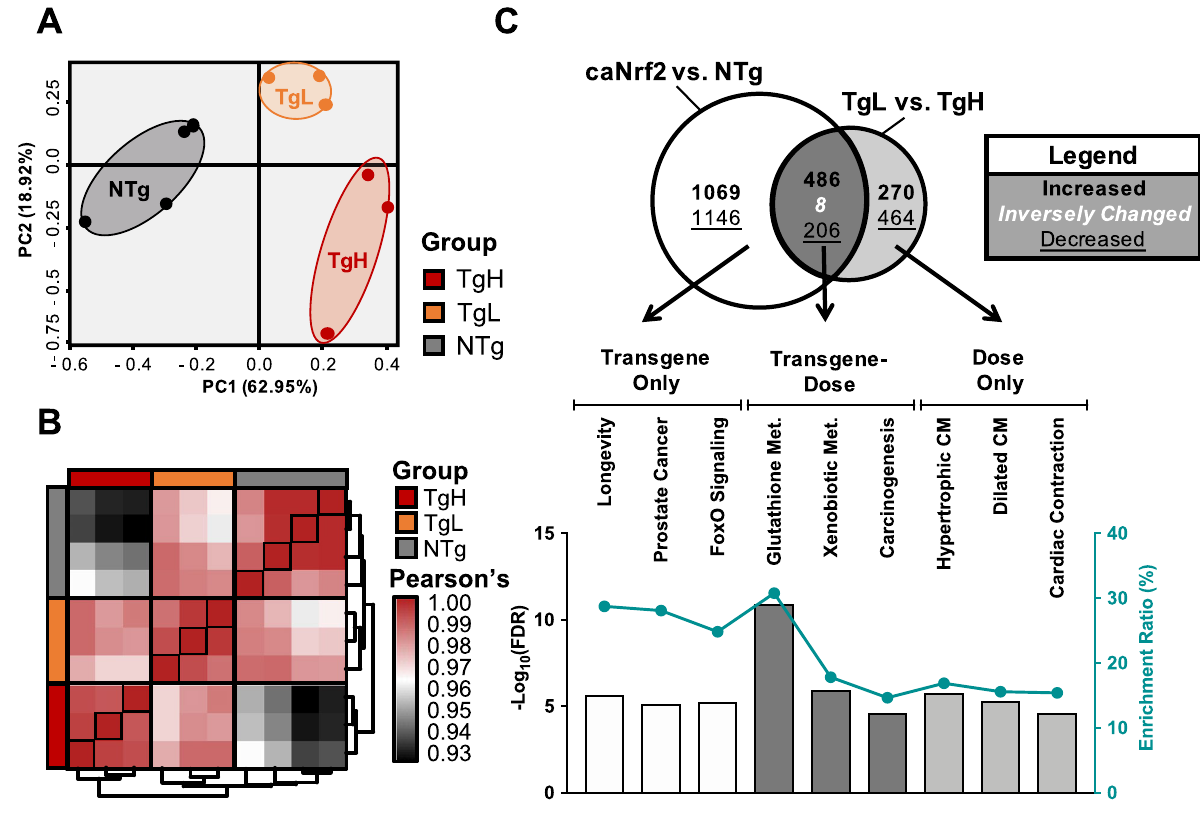
Figure 3. Identification of Direct and Indirect mRNA Targets. ( A ) Unsupervised two-dimensional principal component analysis in R (3.4.2) using normalized counts from non-transgenic (NTg, n = 4), ca Nrf2 transgenic low (TgL, n = 3) and high (TgH, n = 3) mice. ( B ) Unsupervised correlation heatmap according to pearson’s ρ. ( C ) Venn Diagram illustrating the overlap of differentially-expressed genes (DEGs) following pooled “transgene- only”, “transgene-dose” “dose-only” mRNAs ( P < 0.05). The underlying bar graph displays FDR-corrected p-values (left y-axis) and gene enrichment ratio (right y-axis) of the top 3 most-enriched KEGG pathways (ranked by p-value) across the venn diagram regions. Enrichment ratio reflects the percentage of a pathway’s genes significantly altered in the current